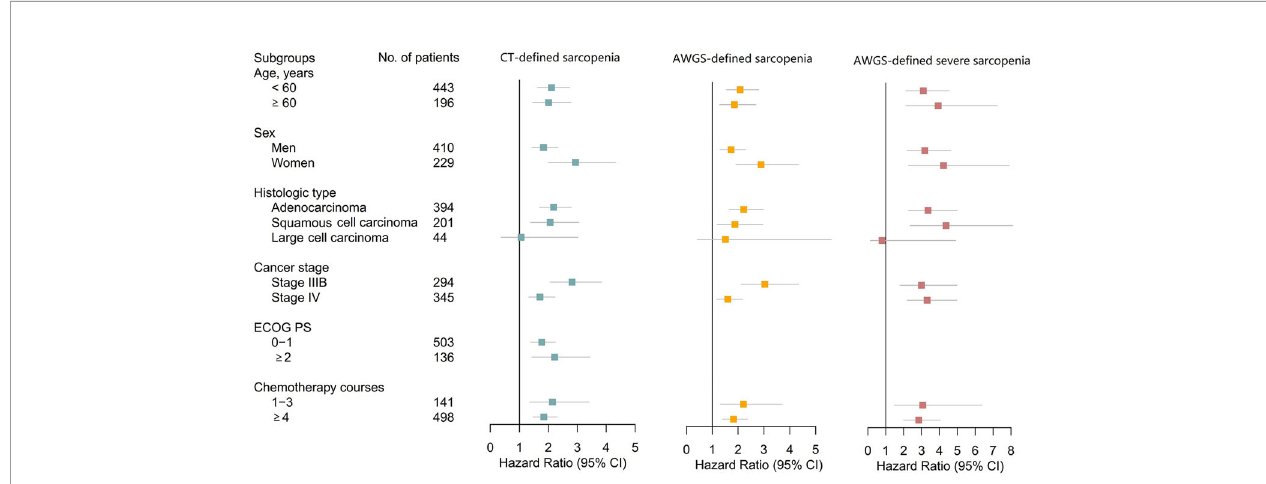
FIGURE 4 | Forest Plots Illustrating Subgroup Analyses According to Age, Sex, Histologic Type, Cancer Stage, ECOG PS, and Chemotherapy Courses. Subgroup analysis according to ECOG PS groups was not performed for AWGS-de fi ned sarcopenia and severe sarcopenia because ECOG PS scores are a component of AWGS-de fi ned sarcopenia and severe sarcopenia. AWGS, Asian Working Group for Sarcopenia; CI, con fi dence interval; CT, computed tomography; ECOG PS, Eastern Cooperative Oncology Group performance status.